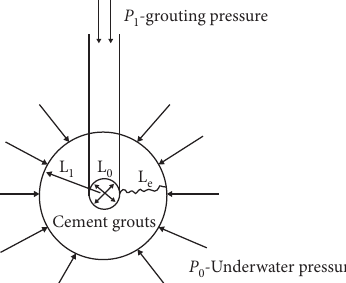
Figure 2: Spherical diffusion model of Newton fluid of time-de- pendent behavior.